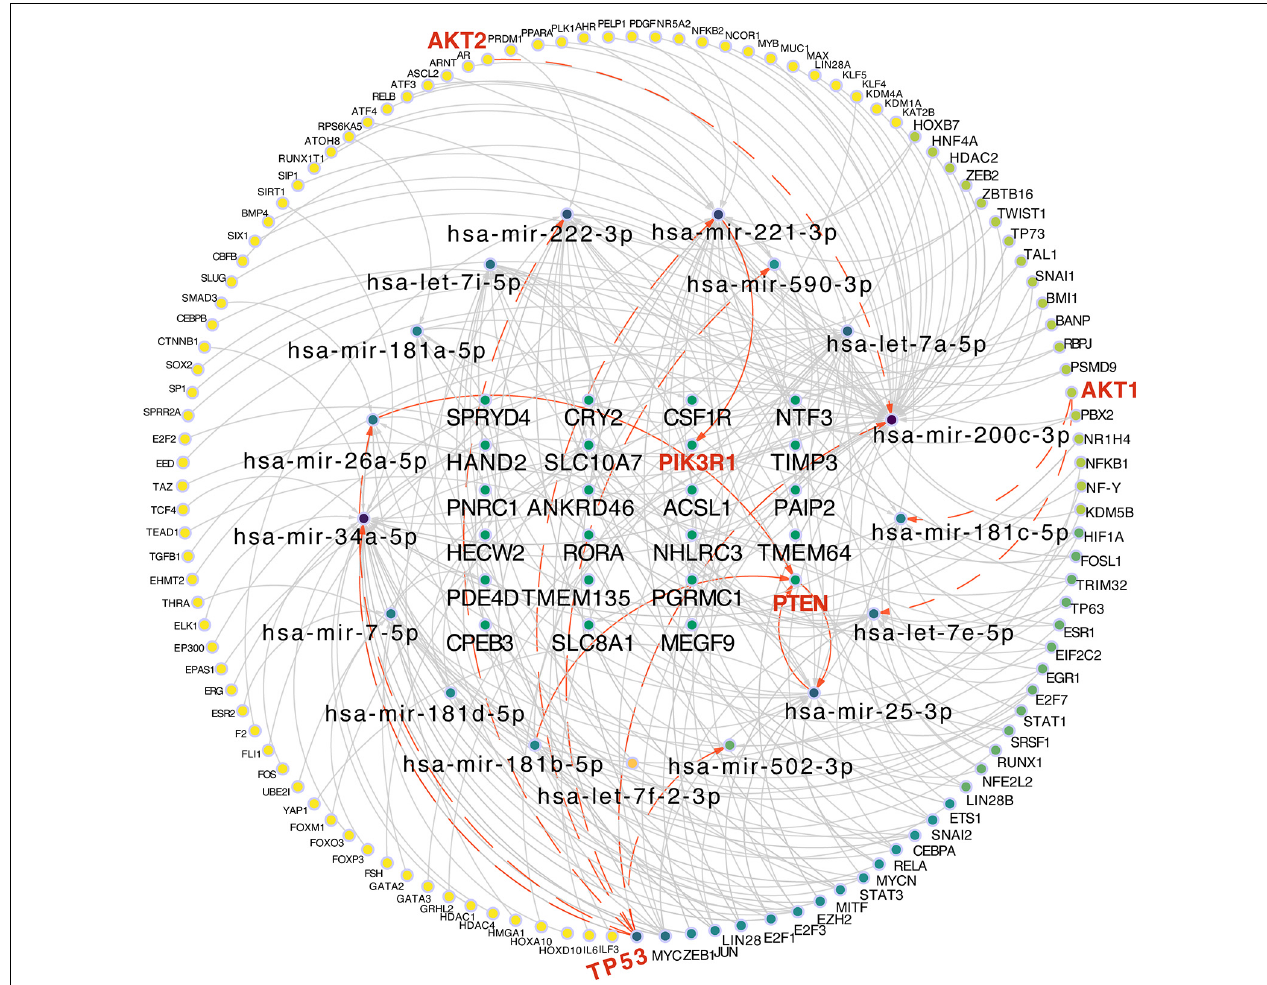
FIGURE 4 | Construction of the “TF-miRNA-target” regulatory network based on 120 TFs, 17miRNAs, and 23 targets. Red and bold labels are the potential molecules included in the “PIK3/AKT” pathway. The line and arrow are the potential regulatory direction between linked